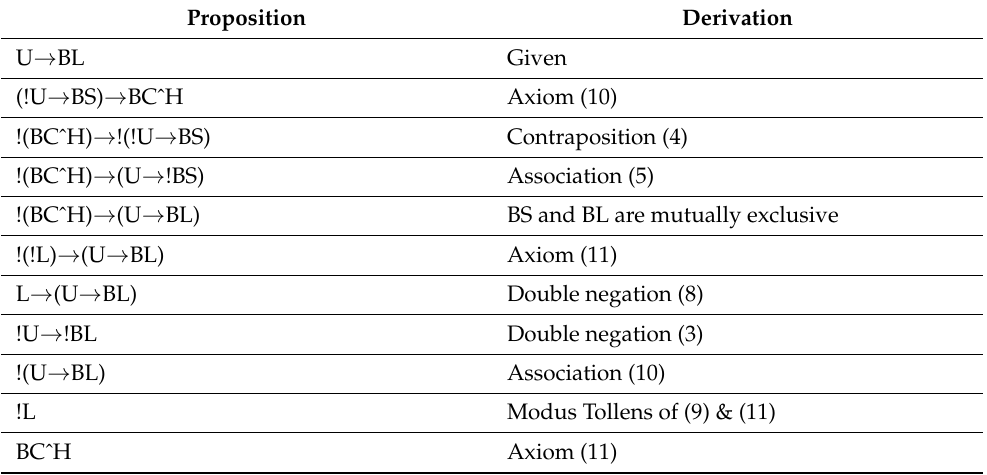
Table 5. Formal proof via contraposition and with malicious user